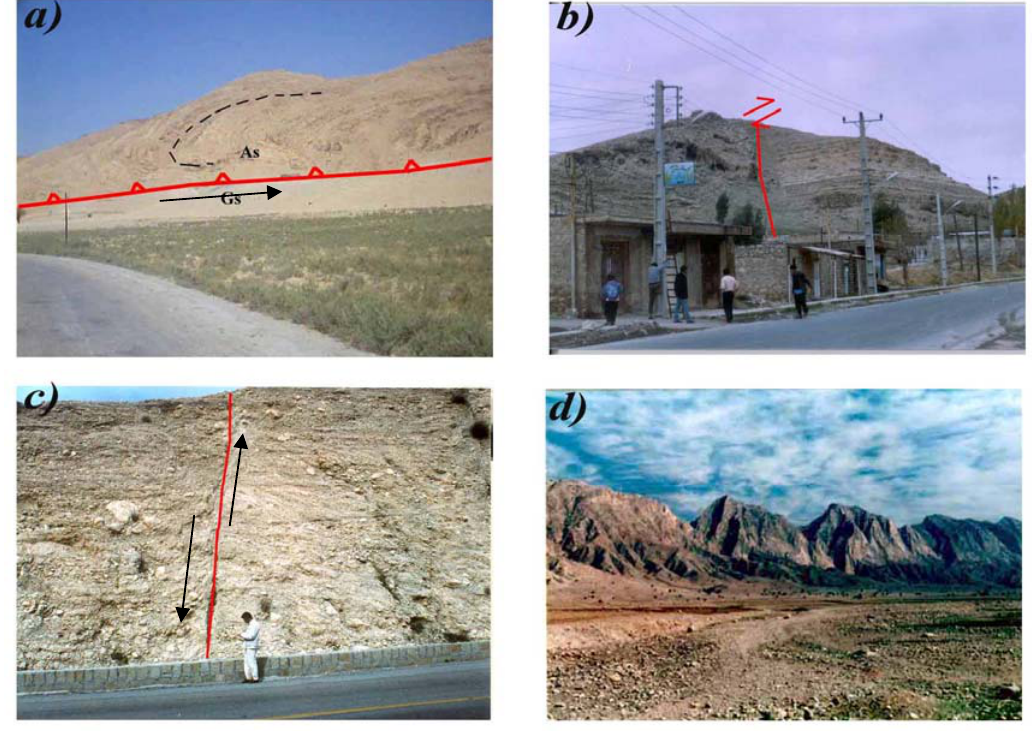
erosion processes. (a) thrust faulting in mountain front; (b) uplifting along fault zone; (c) active faulting in quaternary sediments; (d) bending in mountain